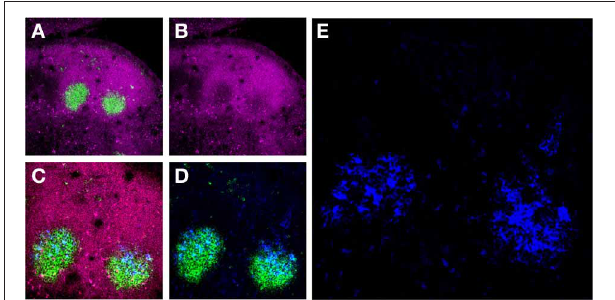
FIGURE 1 | Murine FDCs in lymph node (LN) GCs. (A) Activated GC B-cells labeled with the mAb GL7 (green) are surrounded by a mantle of CD45Rhi (magenta) resting B-cells in two adjacent secondary B-cell follicles in the draining LNs of an immunized mouse. (B) These GC B-cells downregulate CD45R expression upon activation. (C and D) The activated GC B-cells are intimately associated with FDC Ag retaining reticulum (blue). (E) High magnification of the FDC reticulum retaining AMCA-conjugated ovalbumin (blue).